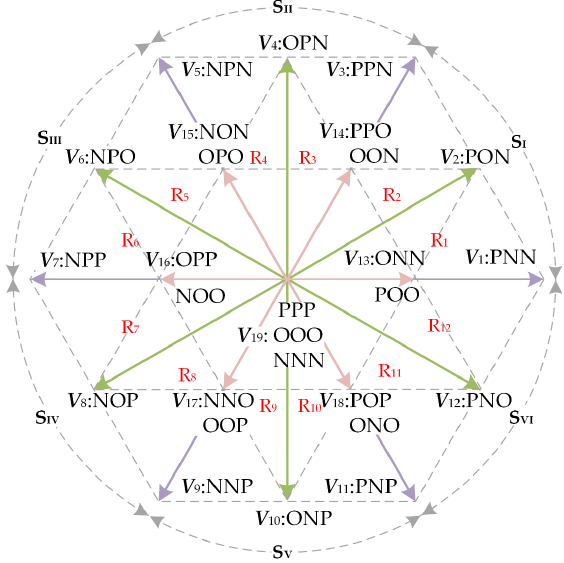
Table 1. Output voltage corresponding to each switching state.